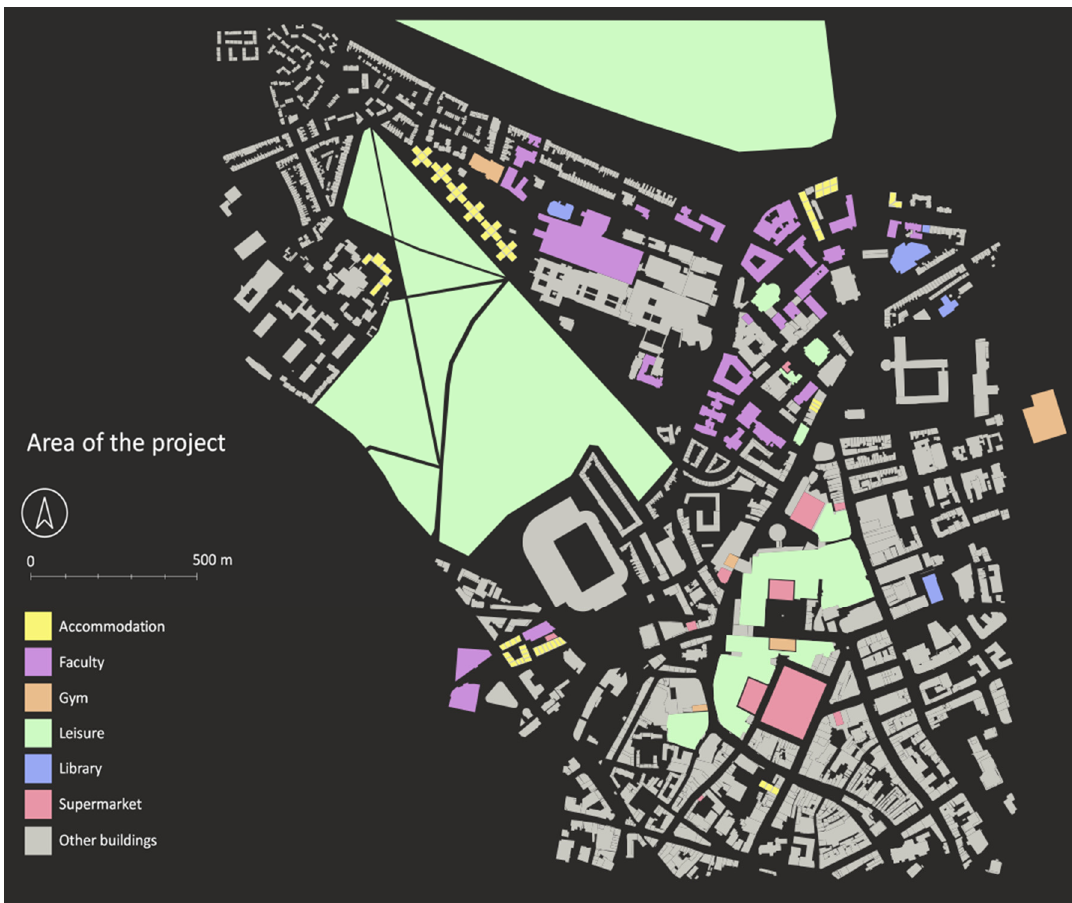
Figure 1. Area of the project in Newcastle upon Tyne, UK, covering the main university campus and surround student accommodation. Buildings are classified in different colours as shown in the legend. Contains Ordnance Survey data © Crown copyright and database right 2020.